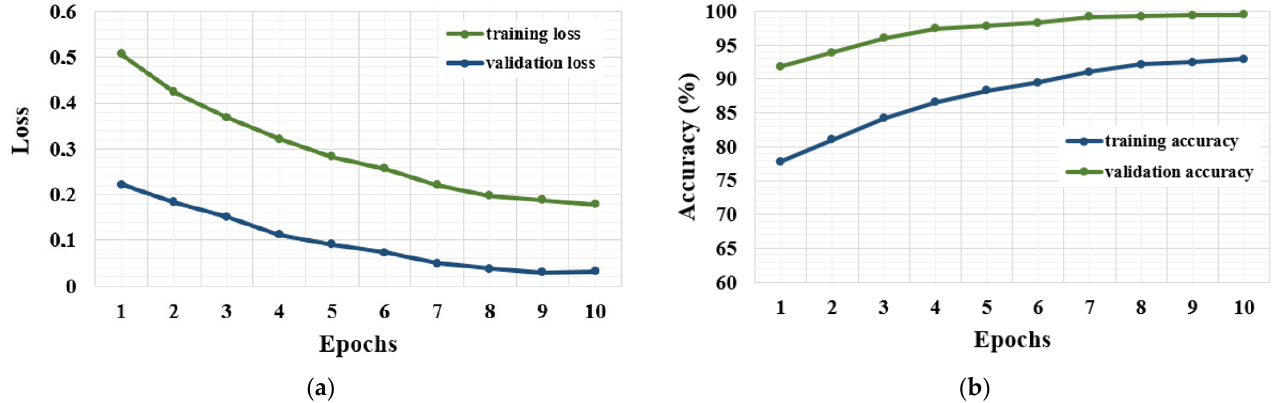
Figure 18. The performance metrics for 20°/30° tooth pro fi le and SNR 15: ( a ) loss-versus-epochs; ( b ) accuracy-versus-epochs graphs.